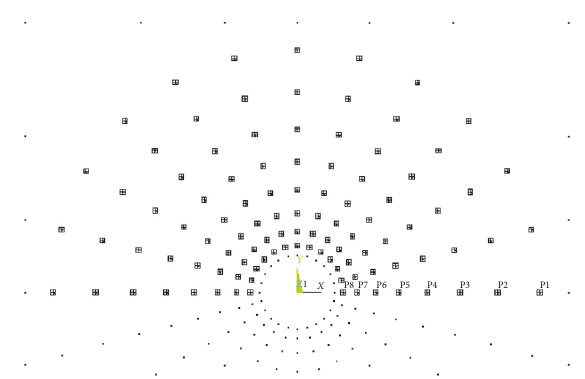
Figure 32: Definition of paths 1–9.